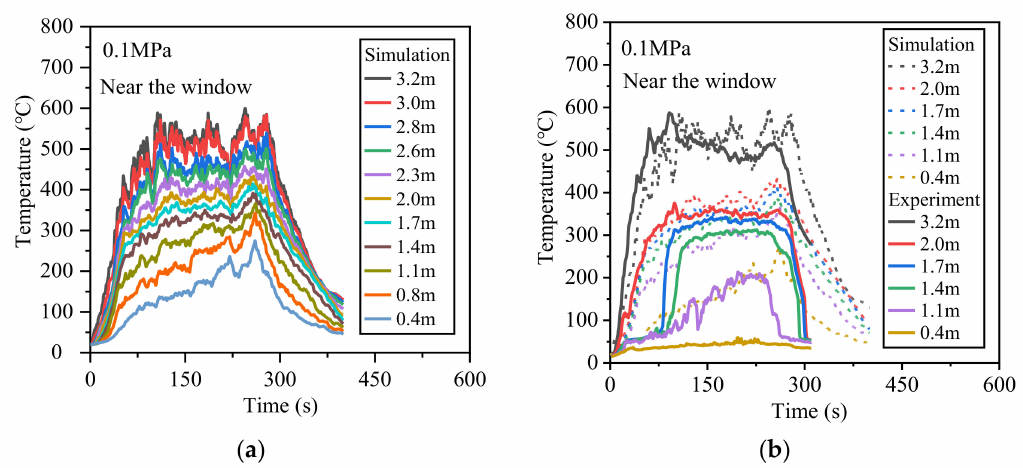
Figure 9. Window sprinkler protection experiment window edge temperature at 0.1 MPa operating Pressure: ( a ) simulation value, ( b ) comparison with experimental value.